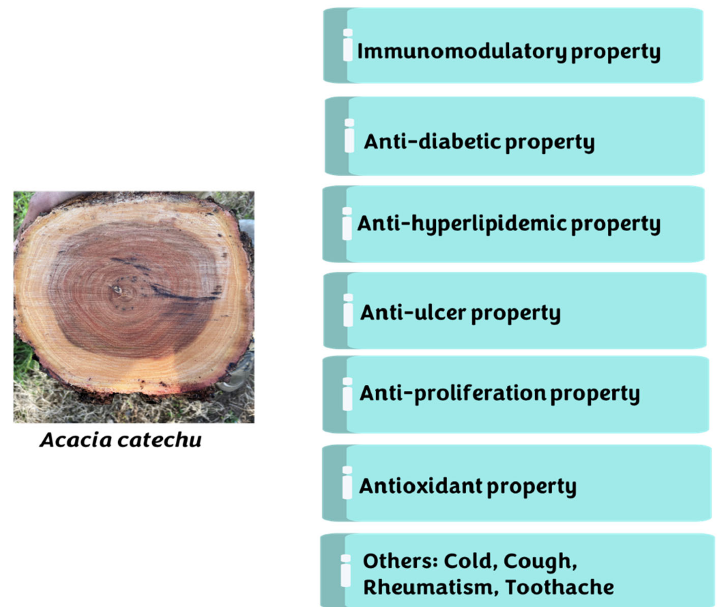
Figure 2. Overview of benefits/properties of Acacia catechu .